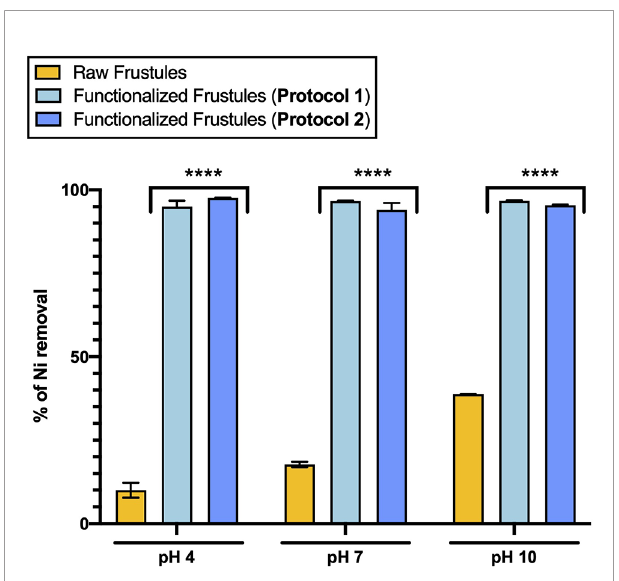
FIGURE 7 | Adsorption of Ni (1.10 mg/L) of functionalized ( Protocol 1 and Protocol 2 ) and raw frustules at three pH conditions after 24-hour treatment. Data are reported as averaged values of triplicates ± standard deviation and analyzed by two-way ANOVA (**** p -value < 0.0001).